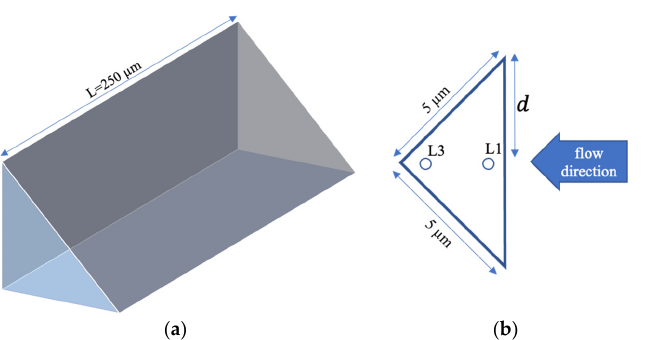
Figure 4. Schematic representation of the volume adopted in the simulations and equivalent to the microstructure corner ( a ). Section of the equivalent volume parallel to the flow direction ( b ).